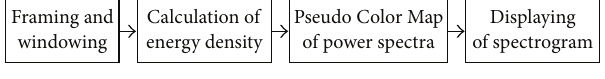
Figure 2: Generation of spectrogram.